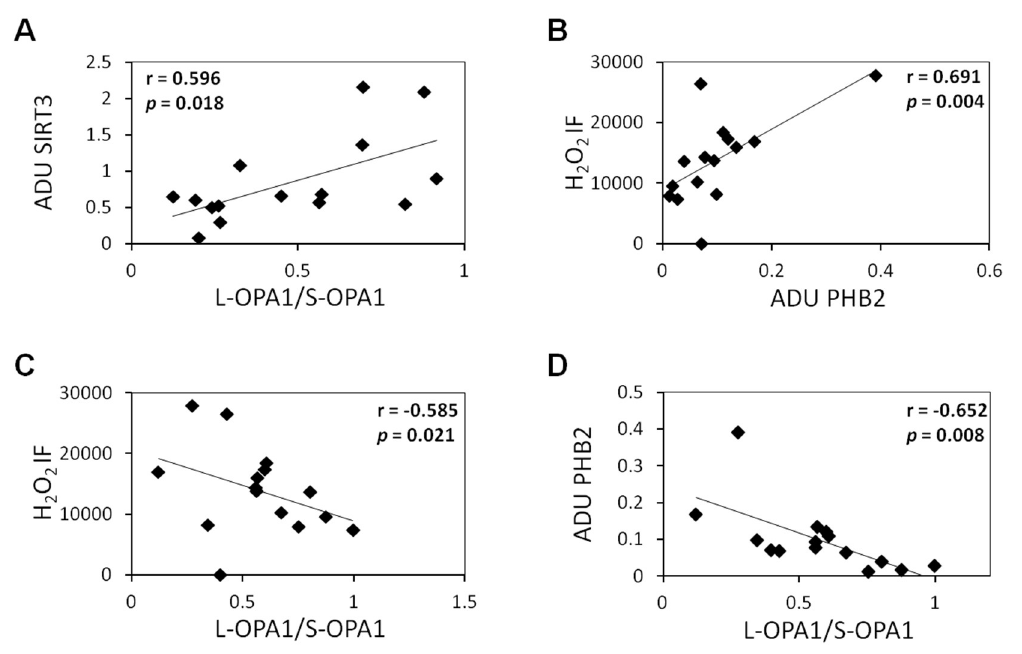
Figure 4. Correlation plots. Empty squares indicates HC group, full squares indicates MS group ( A )Scatter plot and linear regression of data of relationship between SIRT3 protein level, expressed in ADU, and L-OPA1 / S-OPA1 balance in HC group (correlation coe ffi cient, r = 0.596; P , 0.021). ( B ) Scatter plot and linear regression of data of relationship between H 2 O 2 , expressed in intensity of fluorescence (IF), and PHB2 protein level, expressed in ADU in MS group (correlation coe ffi cient, r = − 0.691; P , 0.004). ( C ) Scatter plot and linear regression of data of relationship between H 2 O 2 and L-OPA1 / S-OPA1 balance in MS group (correlation coe ffi cient r = − 0.585, P ,0.021). ( D ) Scatter plot and linear regression of data of relationship between PHB2 protein expression and cleaved long OPA1 (L-OPA1) / cleaved short OPA1 (S-OPA1) balance in MS group (correlation coe ffi cient, r = − 0.652; P = 0.008). Degree of freedom 13.